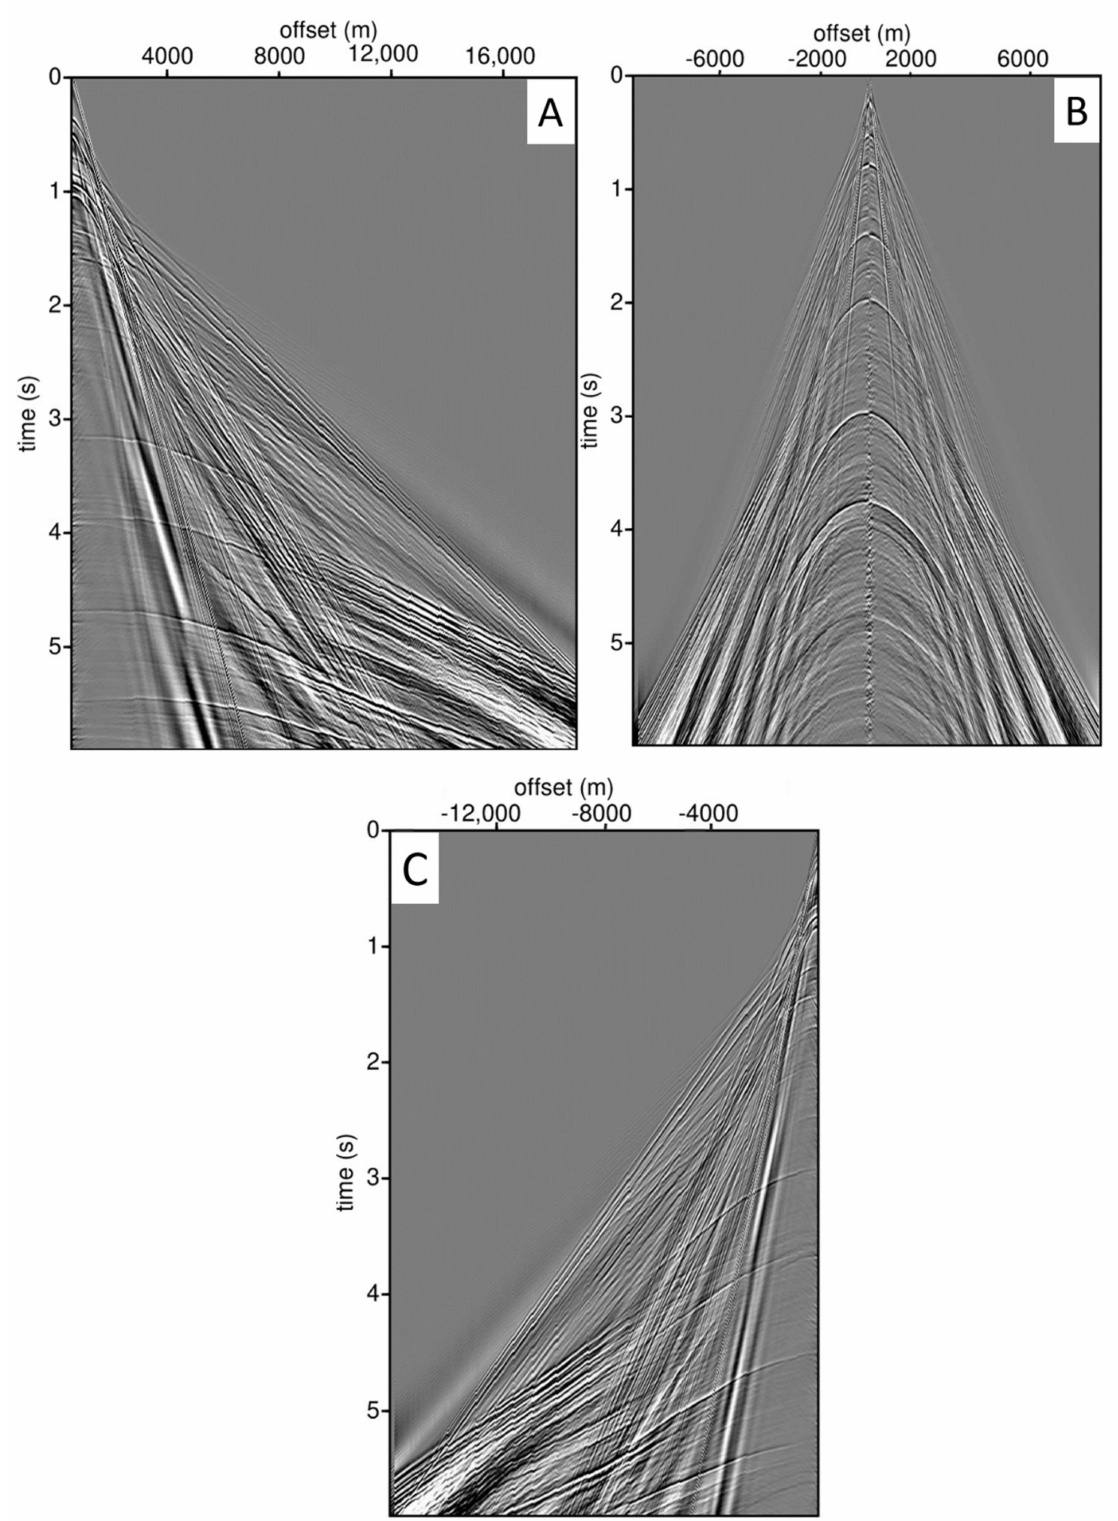
Figure 7. Horizontal component of synthetic seismic data for shot located at ( A ) x = 1 m, ( B ) x = 2000 m, and ( C ) x = 40,000